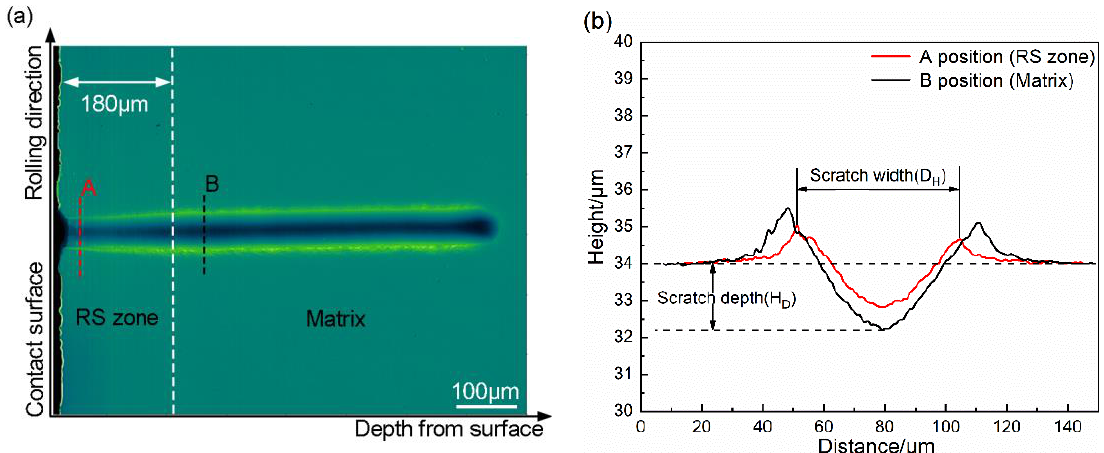
Figure 11. ( a ) Scratch morphology and ( b ) cross-section of positions A and B.